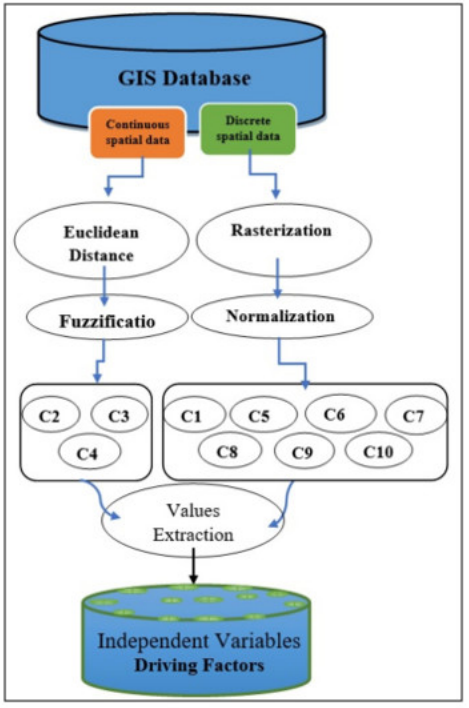
Figure 2. Generating driving factors using spatial-analysis techniques in GIS.